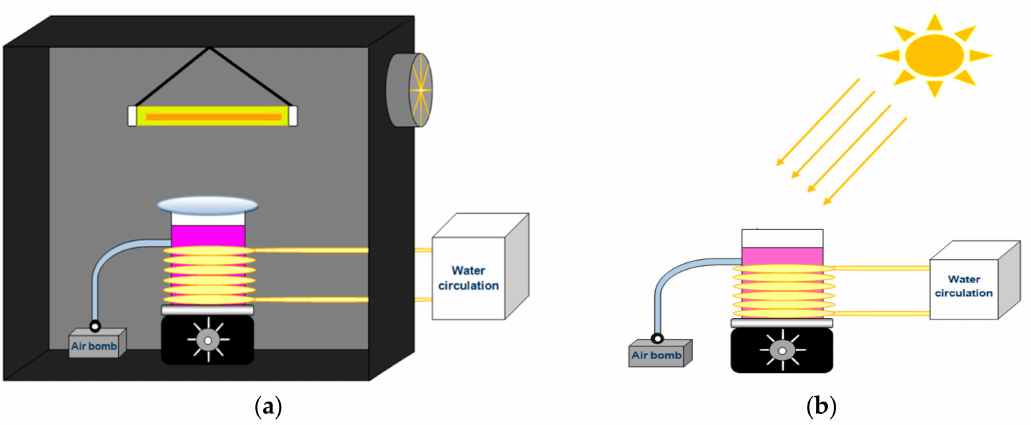
Figure 2. Photocatalytic reactor under 300 W halogen lamp irradiation ( a ) and under natural solar irradiation ( b